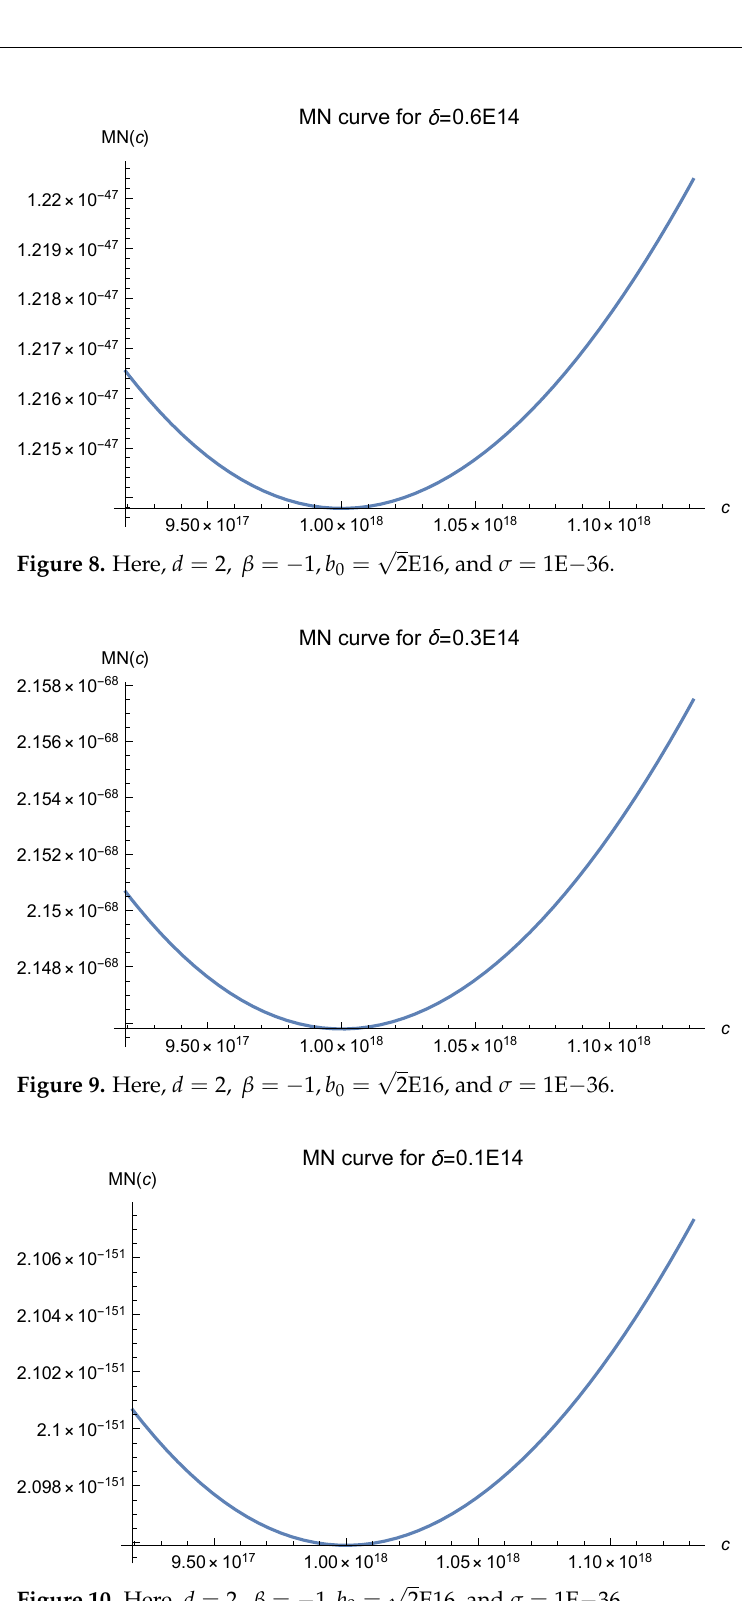
Figure 10. Here, d = 2, β = − 1, b 0 =